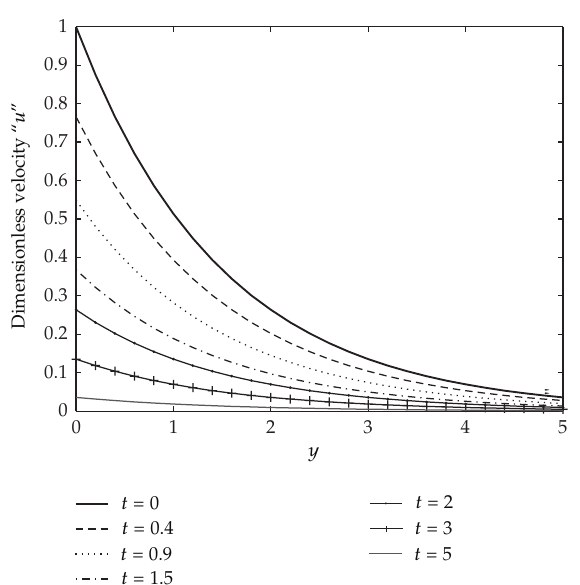
Figure 1: Backward wave-front type travelling wave solution (cid:3) 4.12 (cid:4) varying t when γ (cid:8) 0 . 5, β (cid:8) 2, and c (cid:8) 1 are